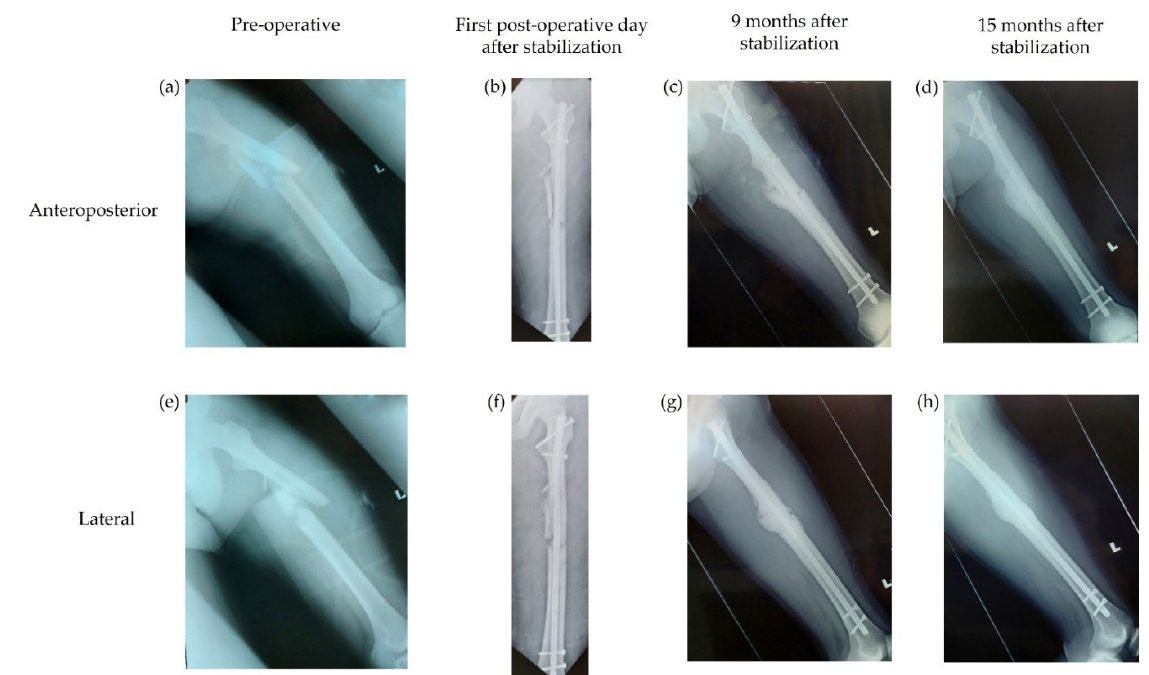
Figure 2. Example of delayed bony union, as assessed by the independent experts. Radiographs from an 18-year-old male patient with a Gustilo type IIIa open femoral fracture. ( a – d ) Anteroposterior radiographs. ( e – h ) Lateral radiographs. ( a , e ) Radiographs taken pre-operatively; ( b , f ) radiographs taken on the first post-operative day after stabilization of the fracture; ( c , g ) radiographs taken 9 months after stabilization; and ( d , h ) radiographs taken 15 months after stabilization that demonstrate bony